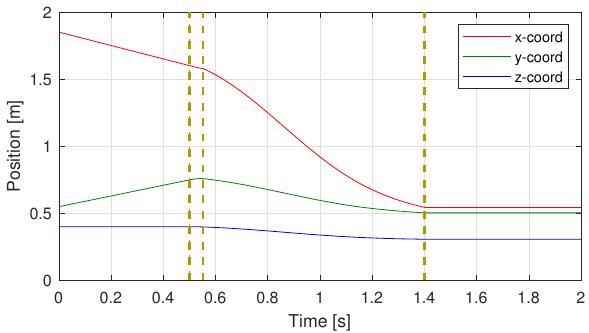
Figure 11. End-effector coordinates during the recovery approach: x ( red ), y ( green ) and z ( blue ). The three dashed lines identify the different phases of the recovery approach: the first one represents the linear motion before failure, followed by the Connecting Path and the straight line path in the third phase; the stationary end-effector at the SP concludes the motion. The recovery strategy affects all three coordinates and they all reach the respective SP coordinate in the same time. cable tensions observable in Figure